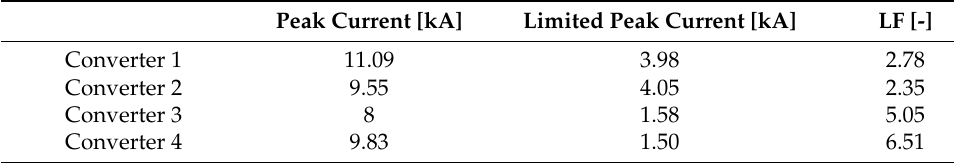
Table 5. Peak current and limiting factor comparison for pole-to-pole